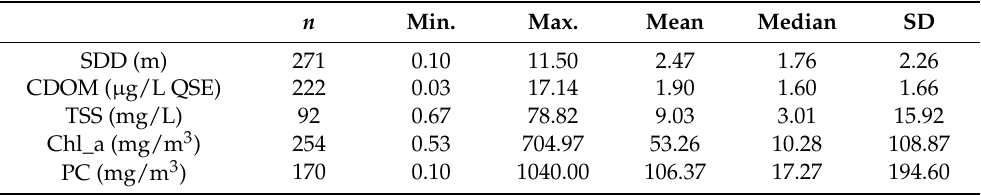
Table 3. Descriptive statistics of the measured water parameters: Secchi disc depth (SDD), coloured dissolved organic matter (CDOM), total suspended sediment (TSS), chlorophyll a (Chl_a), and phycocyanin (PC).